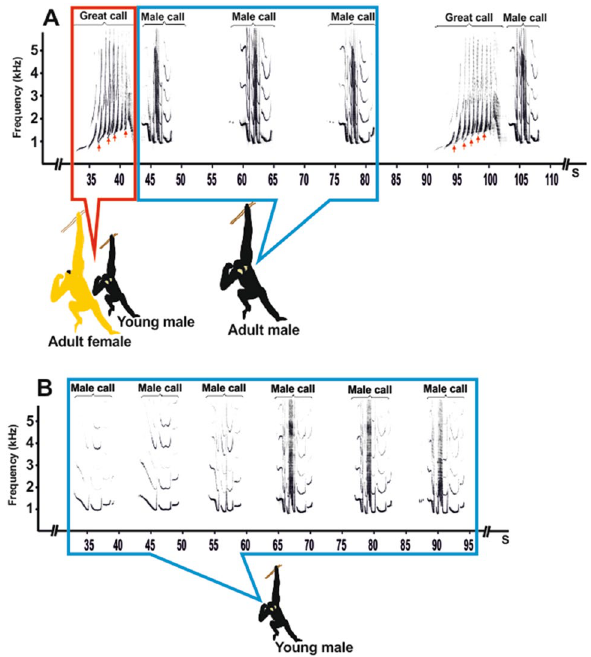
Figure 2. Representative spectrogram indicating the following: ( A) duet bouts between an adult male and an adult female, with an offspring that produces a female-like “great call”; and ( B) a young male emits a male call as a solo song after duet bouts. The red arrows indicate female-like "great calls" emitted by young males in co-singing interactions with their mothers.